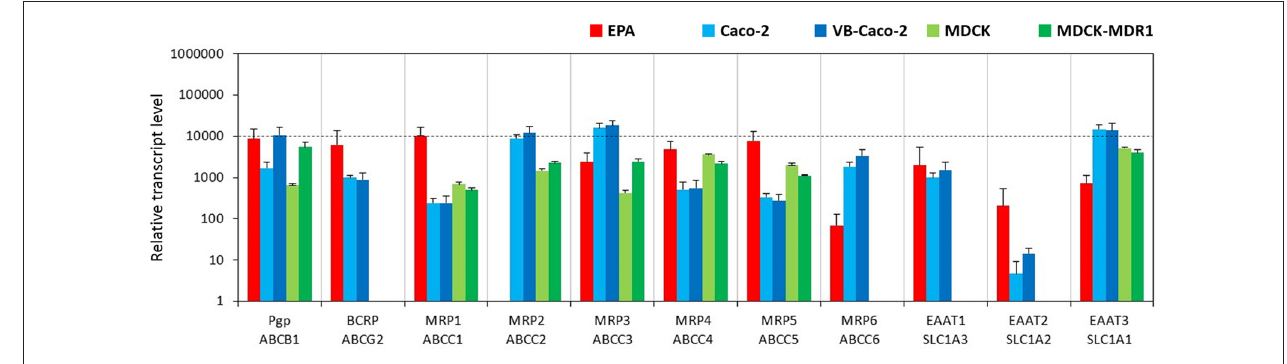
FIGURE 4 | Relative transcript levels of selected genes encoding metabolic enzymes measured by inventoried TaqMan Gene Expression Assays in a primary rat brain endothelial cell-based BBB model (EPA) and in epithelial cell line models (Caco-2, VB-Caco-2, MDCK and MDCK-MDR1). NA: assay not available.